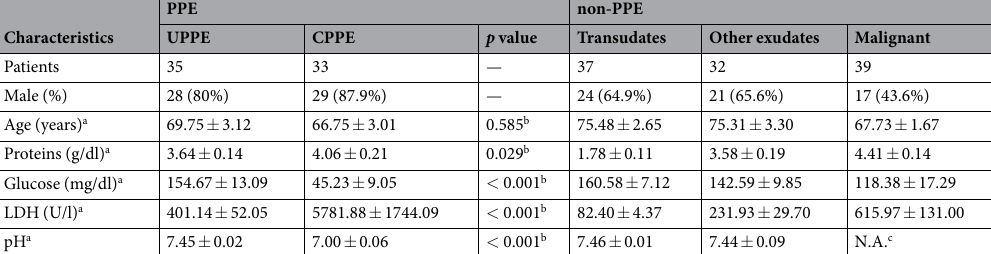
Table 7). Among the three biochemical parameters, the pleural fluid levels of LDH had the best diagnostic value for CPPE, with a sensitivity of 81.8%, a specificity of 100%, a PPV of 100%, and a NPV of 85.4%. Because the BPI optimal cutoff BPI levels in the pleural fluid was 10 ng/ml; the test was considered positive for BPI levels > 10 ng/